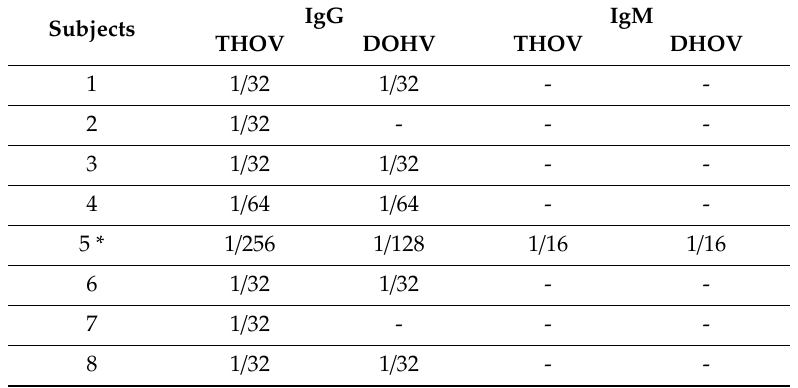
Table1. Humanserumtitersforthestudiedmicroorganisms. THOV:Thogotovirus; DHOV:Dhorivirus.